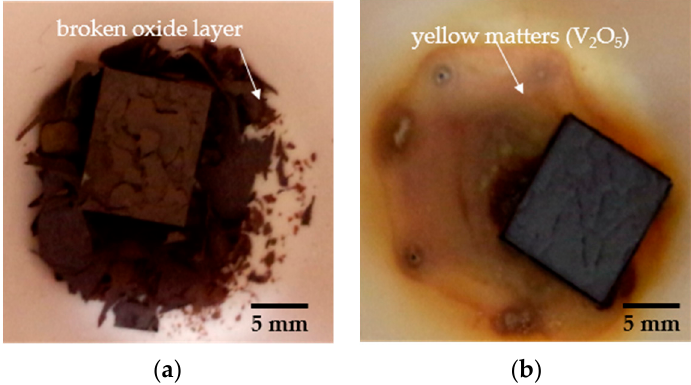
Figure 2. Macroscopic morphologies of TF550 alloy along with Ti–6Al–4V alloy after oxidation at 1073 K for 100 h. ( a ) Ti–6Al–4V and ( b ) TF550.